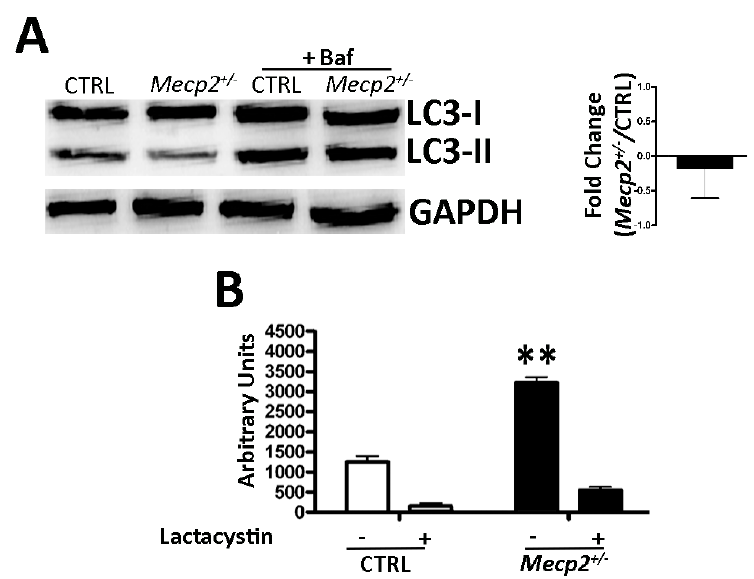
Figure 4. Autophagy and proteasome activity assays. ( A ) Autophagic flux evaluation. The picture shows western blot detection of LC3-I and LC3-II in the Mecp2 +/ − and CTRL MSCs. Mecp2 +/ − and CTRL MSCs were incubated with 100 nM bafilomycin A1 (inhibitor of lysosomal degradation) or phosphate-bu ff ered saline (PBS) to detect autophagic flux. We used Gel Doc 2000 Gel Documentation Systems (Bio-Rad, Hercules, CA, USA) to measure LC3-I and II band intensities that were normalized with GAPDH as internal control. We determined autophagic flux (AF) for LC3 II as follows: Mecp2 +/ − MSC AF = (Mecp2 +/ − MSCs + Bafilomycin A1) − (Mecp2 +/ − MSCs + PBS); CTRL MSC AF = (CTRL MSCs + Bafilomycin A1) − (CTRL MSCs + PBS). Change in autophagic flux ( ∆ AF) between Mecp2 +/ − and CTRL MSCs was calculated as follows: ∆ AF = Mecp2 +/ − MSC AF − CTRL MSC AF. The graph shows AF changes in the Mecp2 +/ − MSCs compared to CTRL cells. The data are expressed in change folds ( ± SD, n = 5). ( B ) Proteasome activity. Mecp2 +/ − and CTRL cells were harvested for a fluorometric assay determination of proteasome activity. Mecp2 +/ − and CTRL cultures were incubated with 25 µ M lactacystin (a specific inhibitor of proteasomes) or PBS. The graph shows proteasome activity in the Mecp2 +/ − and CTRL cells both in the presence and absence of lactacystin. Data are expressed in arbitrary units ( ± SD, n = 5; ** p < 0.01) The asterisk denotes significant di ff erences between Mecp2 +/ − samples versus CTRL